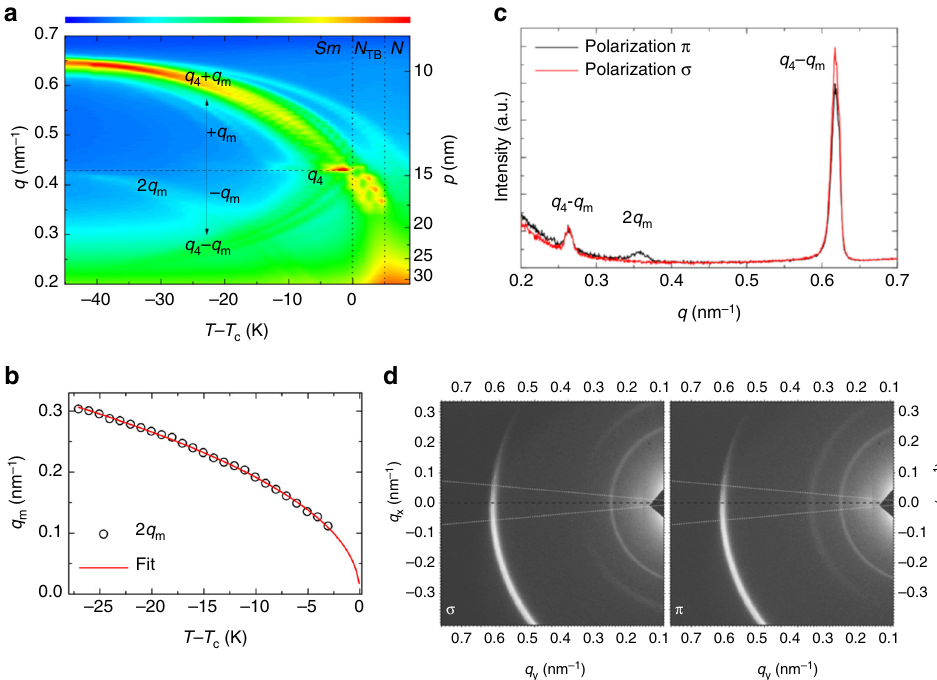
Fig. 2 The resonant soft X-ray scattering for material D1 . a Temperature ( T ) evolution of the scattering wave vector magnitudes ( q ) and the corresponding periodicities ( p ) of the RSoXS signals measured on heating, the intensity of the signals is coded by colors, scale bar is given above. At the transition temperature ( T c ) from the N TB to the smectic phase, the signal locks at q = q 4 , which corresponds to four smectic layer distances. This signal re fl ects the ideal clock-like helix in the smectic phase. For few degrees below the N TB − smectic phase transition, the q 4 signal coexists with the signals q 4 – q m and q 4 + q m , which are related to the distorted helical structure. The weak 2 q m signal is also visible. The range in which both structures, the distorted and ideal clock- like helix, coexist depends on the cooling/heating rate (see Supplementary Fig. 4). b The temperature dependence of the 2 q m signal; the red line represents ¼ 2 q the fi t to the critical dependence 2 q T 0 : 45 with 2 q m0 = 0.6 nm − 1 , T r = ( T c − T )/ T c being the reduced temperature. c Intensity of signals vs. wave m m 0 r vector magnitude q obtained by integration of the 2D RSoXS patterns ( d ) registered for the π and σ polarization of the incident beam. Only the areas marked by white cones in ( d ) were analyzed. The q 4 – q m and q 4 + q m signals are independent of the polarization of the incident beam, whereas the 2 q